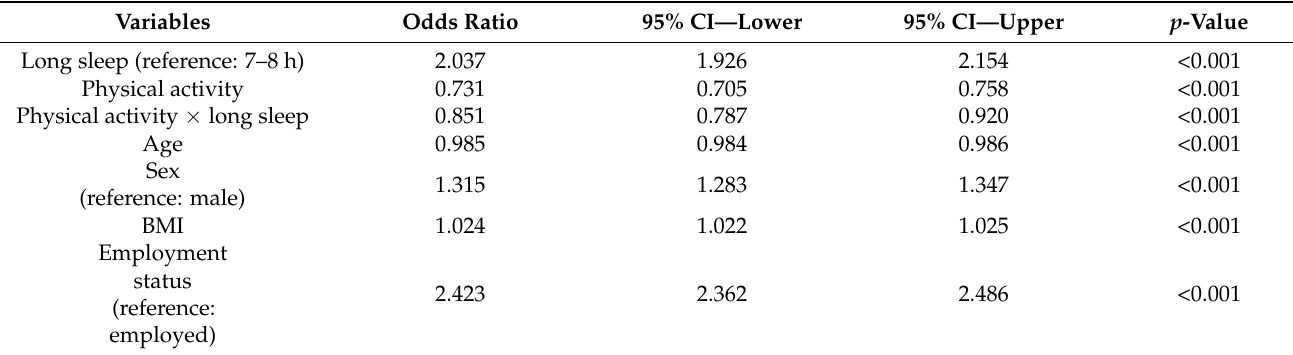
Table 9. The moderating effect of physical activity on the relationship between long sleep and emotional distress among Blacks and Whites ( n =